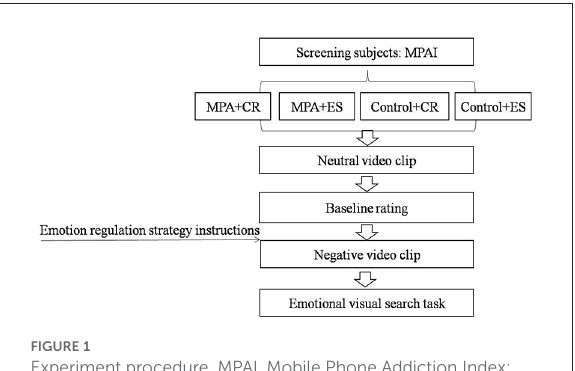
evoked video materials respectively. Both video clips lasted